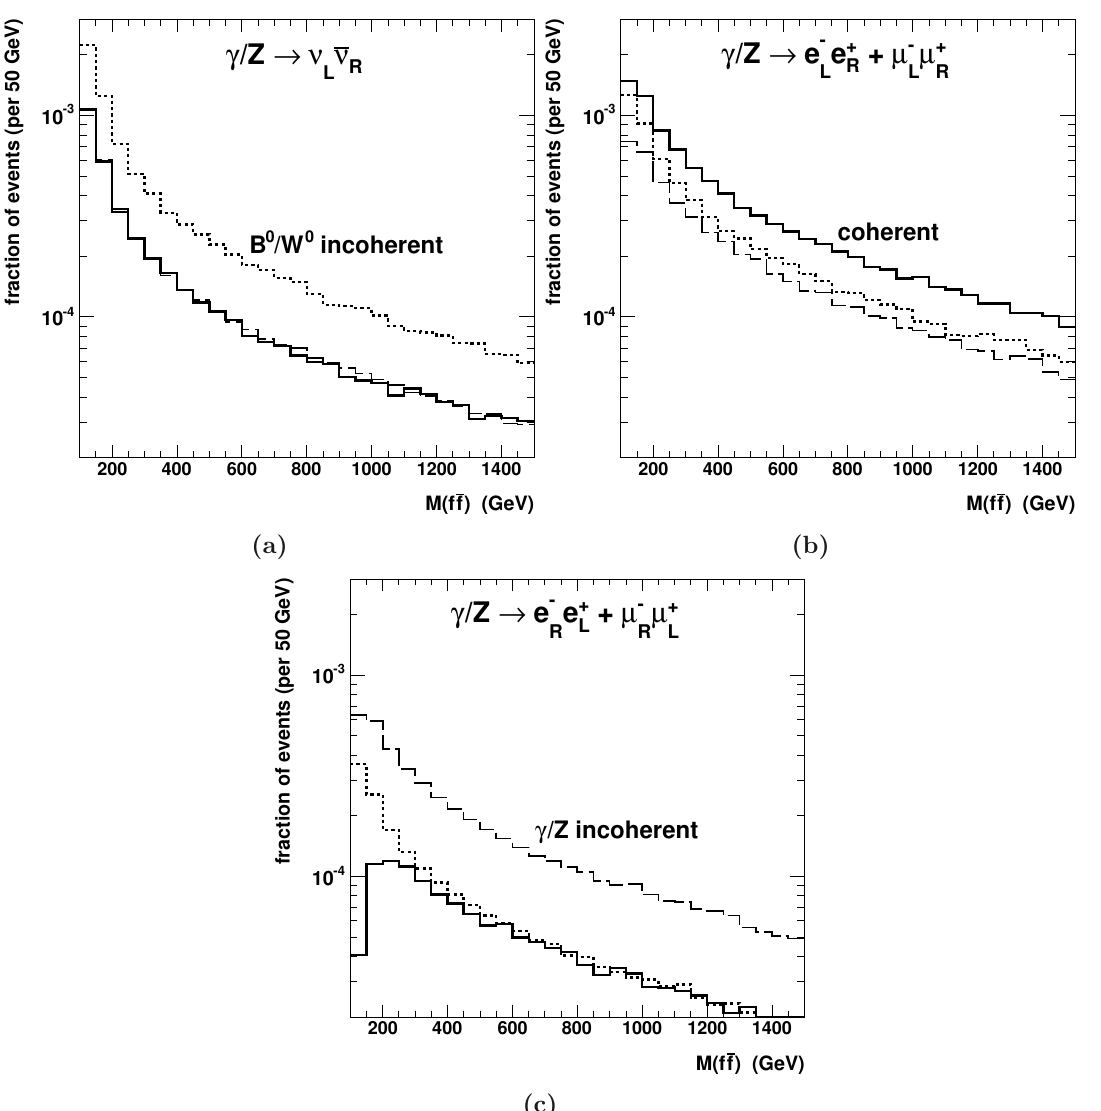
Figure 8. Invariant mass distributions for fermion pairs produced in the EW splitting of a 2.5 TeV γ/Z neutral boson, sourced by an e L current, for exclusive final states (a) ν L ¯ ν R , (b) ℓ −